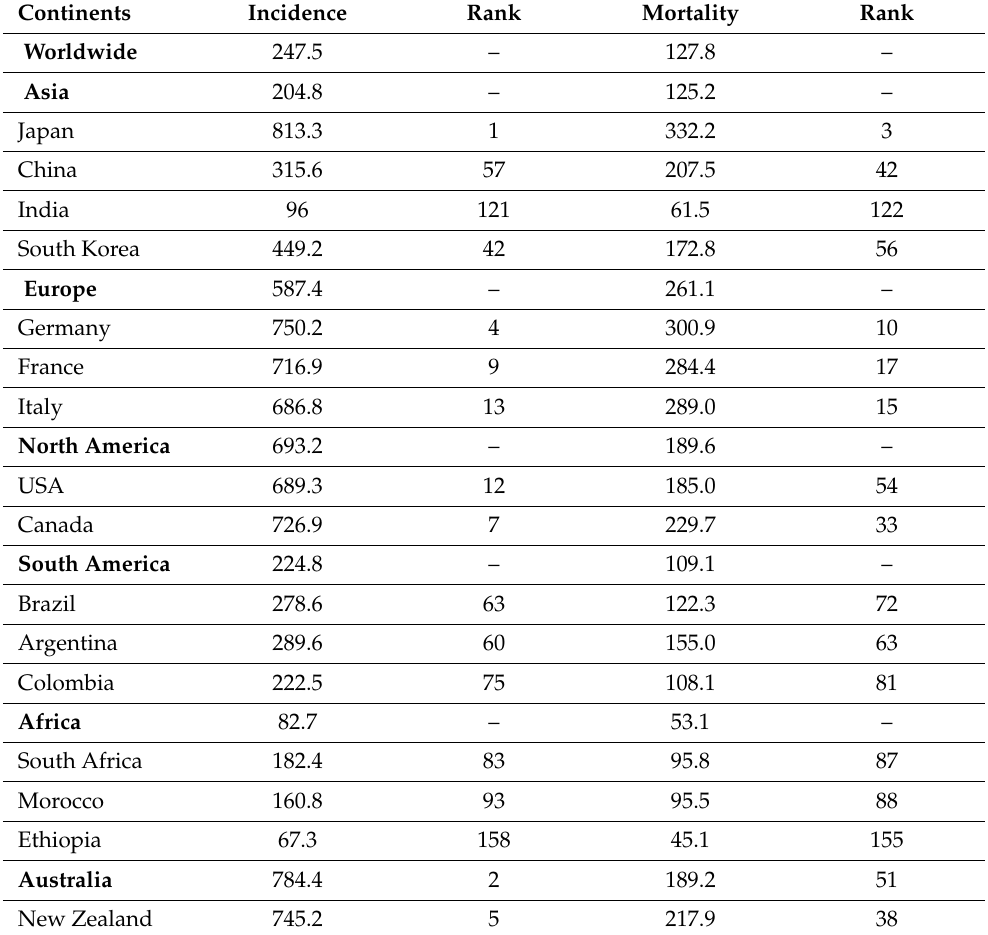
Table 1. Estimated worldwide incidence and mortality rates (per 100,000 people) of all cancer types in